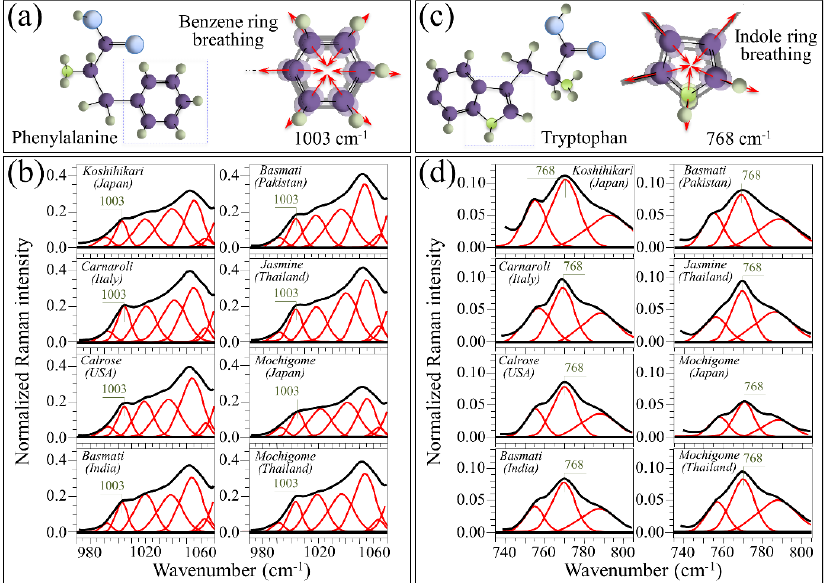
Figure 5. ( a ) Draft of the molecular structure of phenylalanine and breathing vibrations of its benzene ring (Raman line at ~1003 cm − 1 ), and ( b ) high-resolution (deconvoluted) Raman spectra of different rice cultivars (cf. labels in inset) in the spectral region 970–1070 cm − 1 ; ( c ) draft of the molecular structure of the aromatic amino acid tryptophan and its indole ring breathing vibration at ~768 cm − 1 , and ( d ) high resolution (deconvoluted) Raman spectra of different rice cultivars (cf. labels in inset) in the region 735–805 cm − 1 .